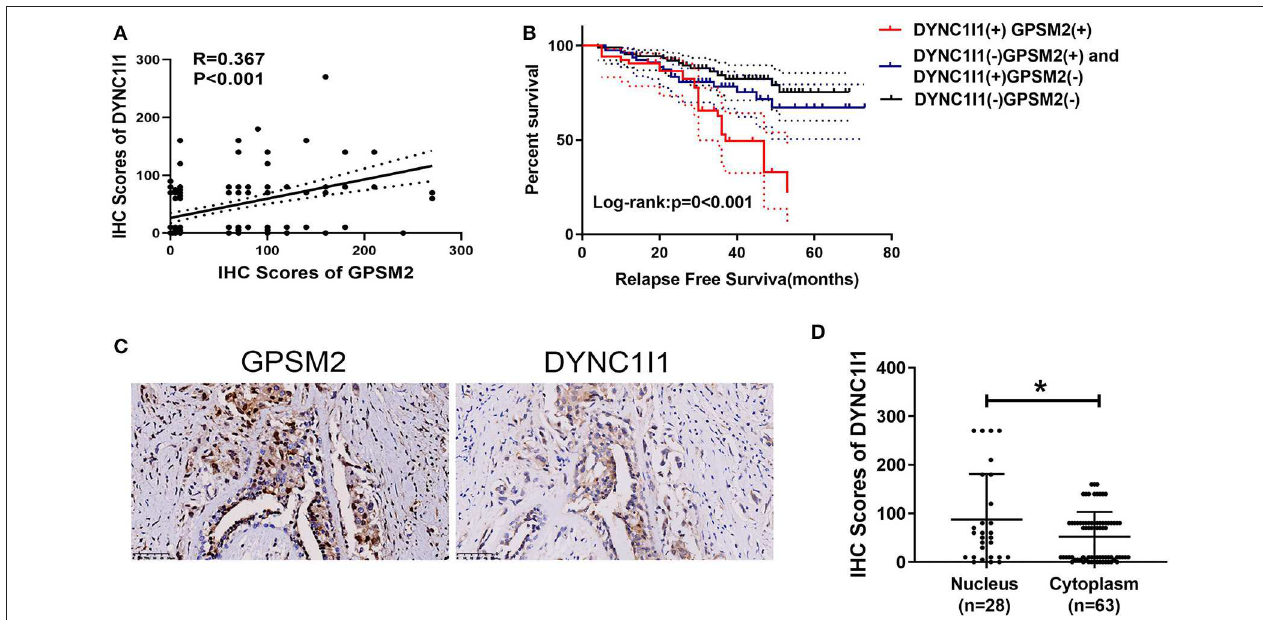
FIGURE 5 | Correlations between GPSM2 expression and DYNC1I1 in breast cancer patients. (A) The IHC scores of GPSM2 is positively correlated with the IHC scores of DYNC1I1 ( R = 0.367, p < 0.001); (B) Kaplan-Meier survival analysis and log-rank test indicated that the RFS of patients exhibiting expression of both DYNC1I1 and GPSM2 was significantly reduced compared to other patients ( p < 0.001); (C) GPSM2 and DYNC1I1 expression; (D) IHC scores of DYNC1I1 in the GPSM2-nucleus group were significantly higher than the GPSM2-cytoplasm group ( p < 0.05); * p < 0.05 (vs. control group).